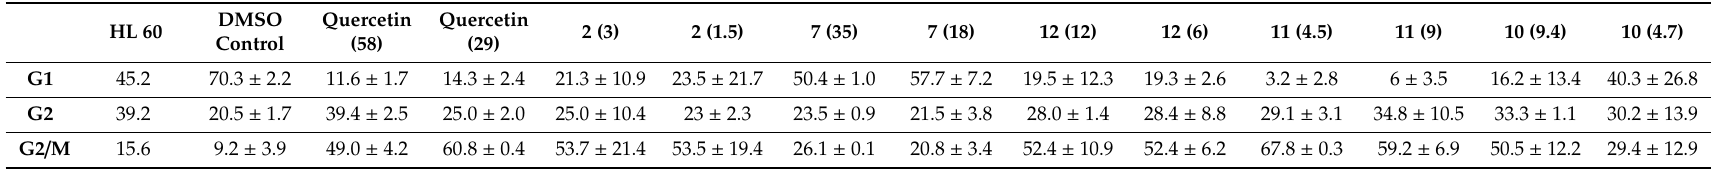
Table 4. The cell cycle distribution of HL 60 cells after treatment with test compounds. The results are given as mean +/ − standars deviation. The concentrations of the compounds (in µ M) are given in the parenthesis and correspond to 1 × IC 50 and 0.5 × IC 50 ( µ M). (n = 2) n-number of repetition (see Figure